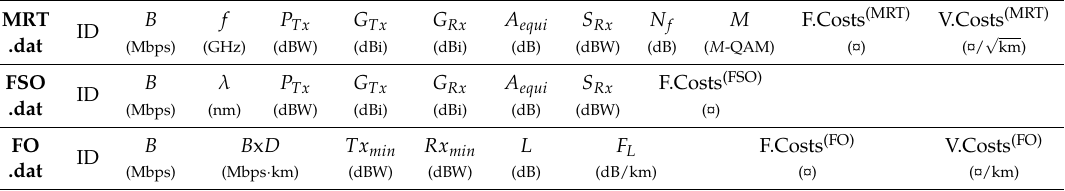
Table 2. Required inputs for the “MRT.dat”, “FSO.dat”, and “FO.dat” files.